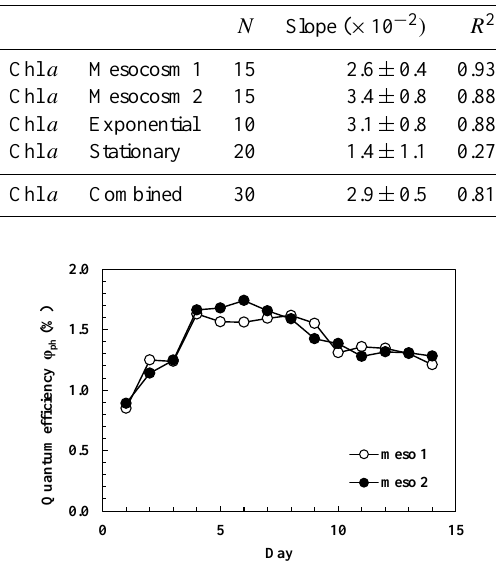
Figure 6. Development in time (days) of quantum efficiency ϕ ph de- rived from total phytoplankton absorption and fluorescence in two mesocosms.